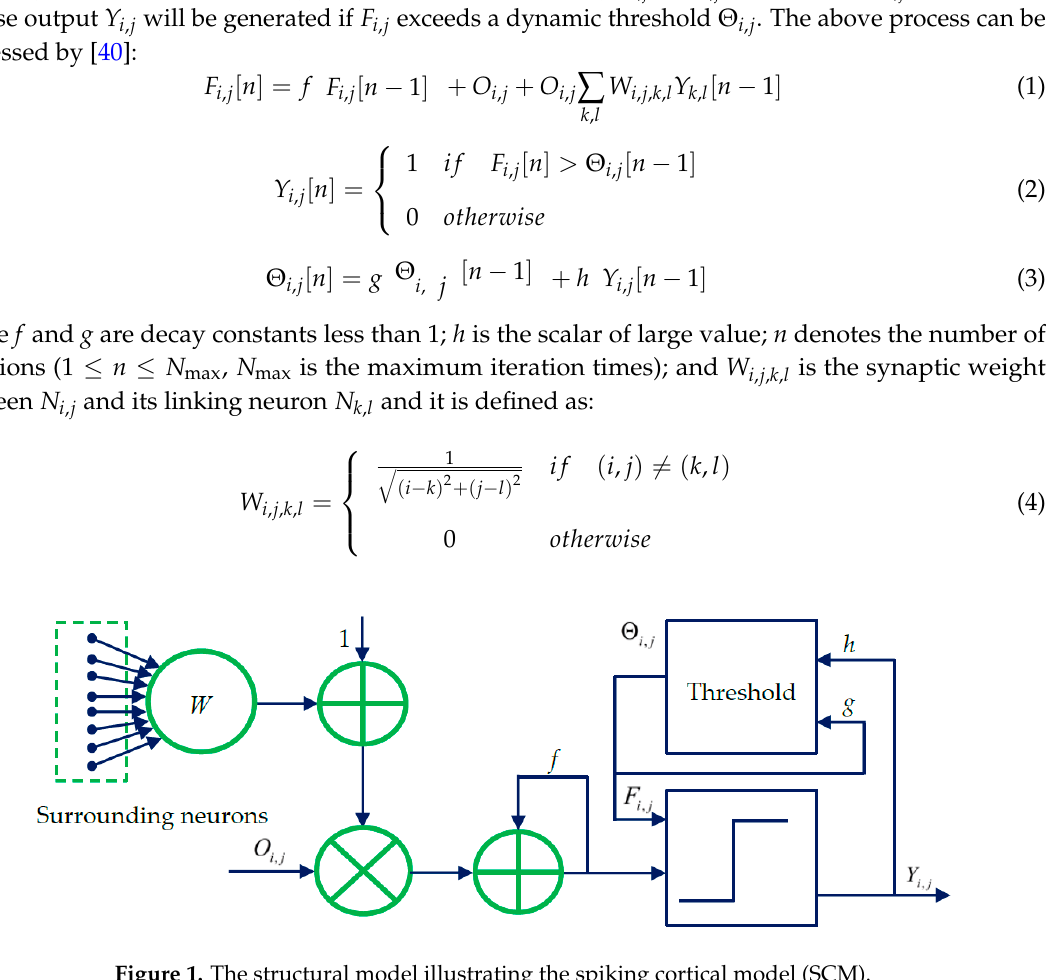
Figure 1. The structural model illustrating the spiking cortical model (SCM).